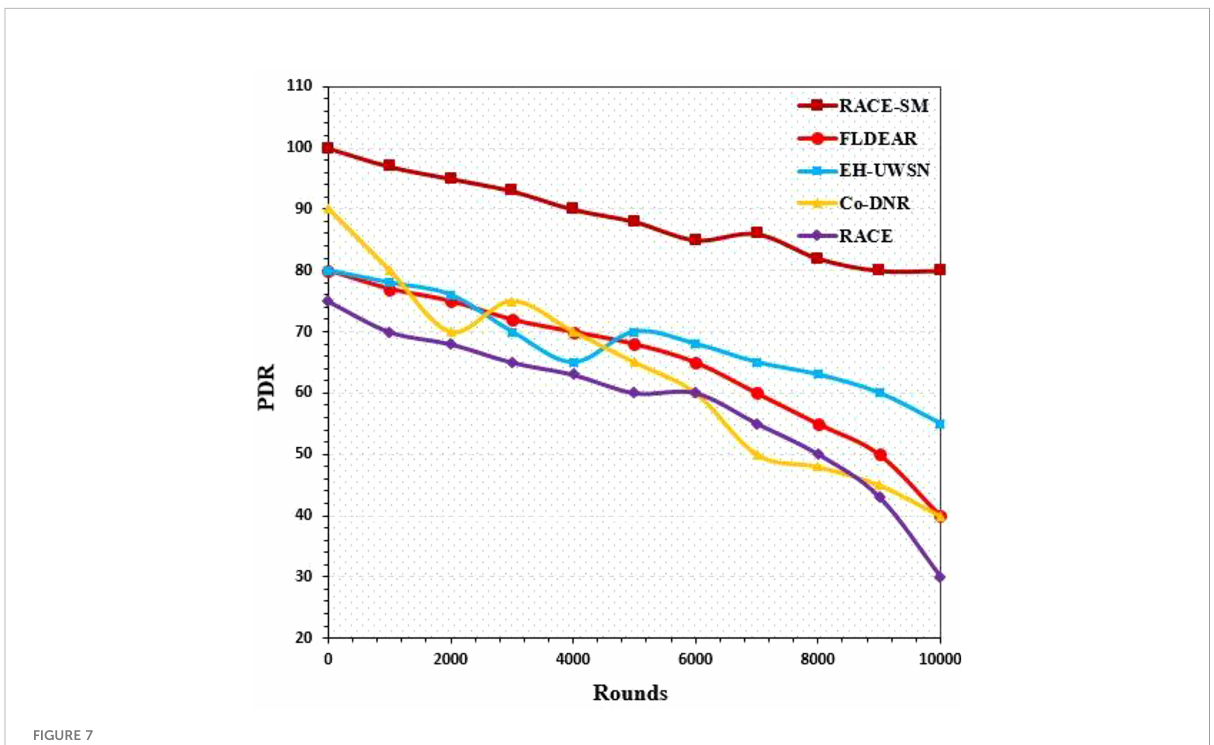
FIGURE 7 Packet Delivery Ratio